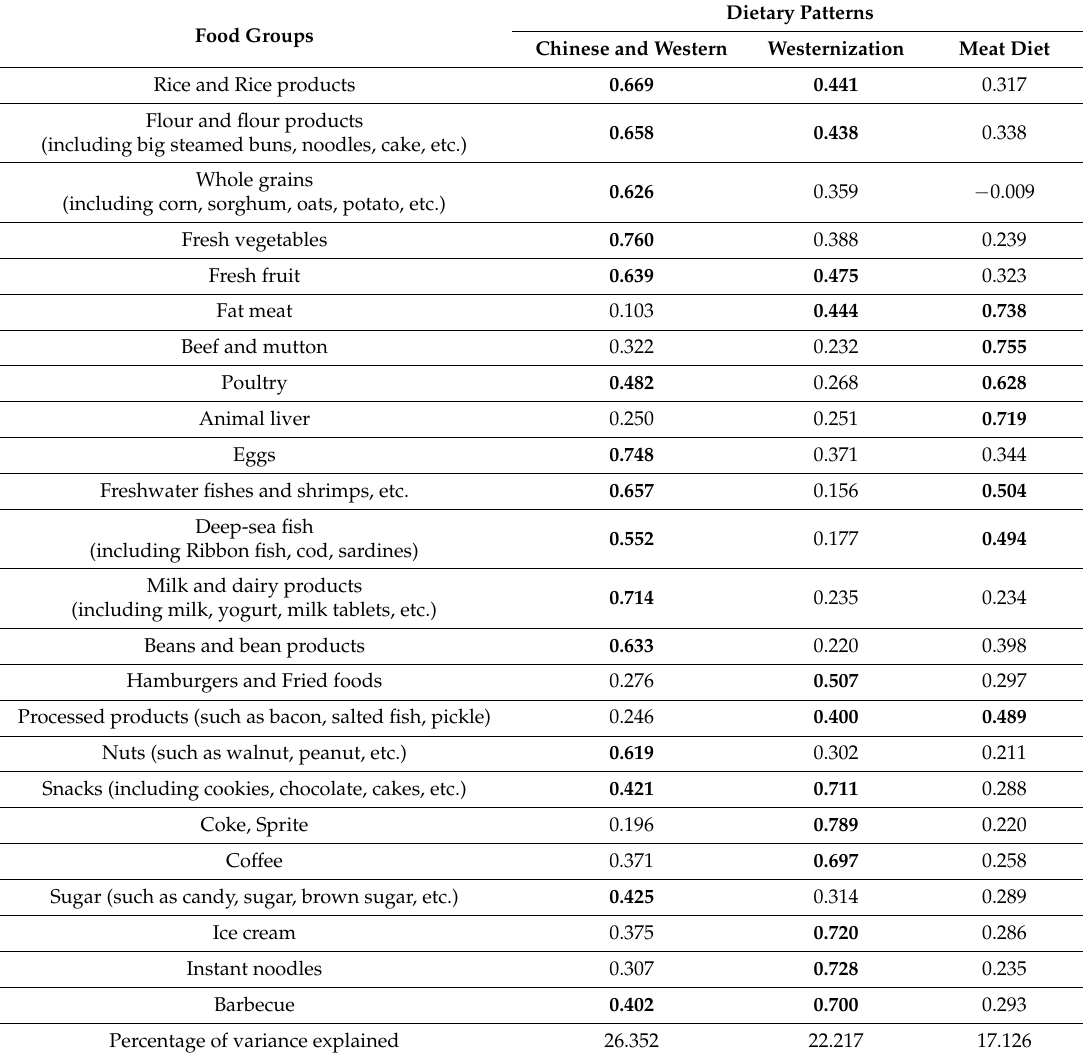
Table 1. Factor loadings for major dietary